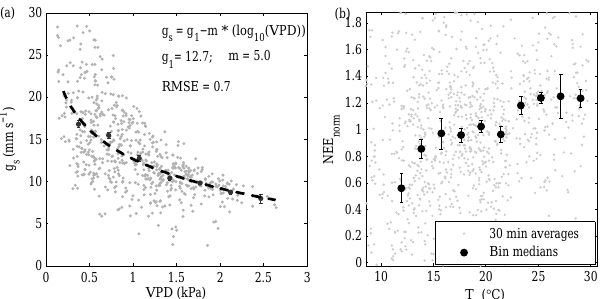
Figure 10. (a) Surface conductance versus vapour pressure deficit demonstrating a well-known relationship. The dashed line is a fit (the function is specified in the insert). (b) Normalized NEE (NEE norm = NEE / NEE mod ) versus air temperature for June–July 2015; NEE norm saturates approaching 25 ◦